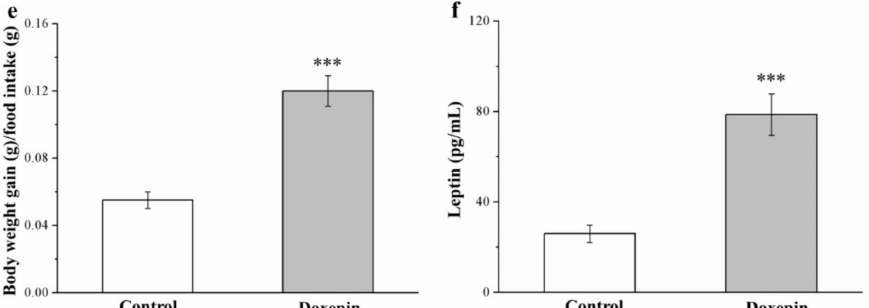
Figure 1. ( a ) Body weight, ( b ) body weight change, ( c ) body weight gain, ( d ) weekly food intake, ( e ) daily food efficiency, and ( f ) serum leptin levels in control and doxepin-treated obese mice over 56 days of treatment. All values represent means ± standard deviations ( n = 10 for all groups). ** p < 0.01 and *** p < 0.001 indicate high and very high statistical significance, respectively.